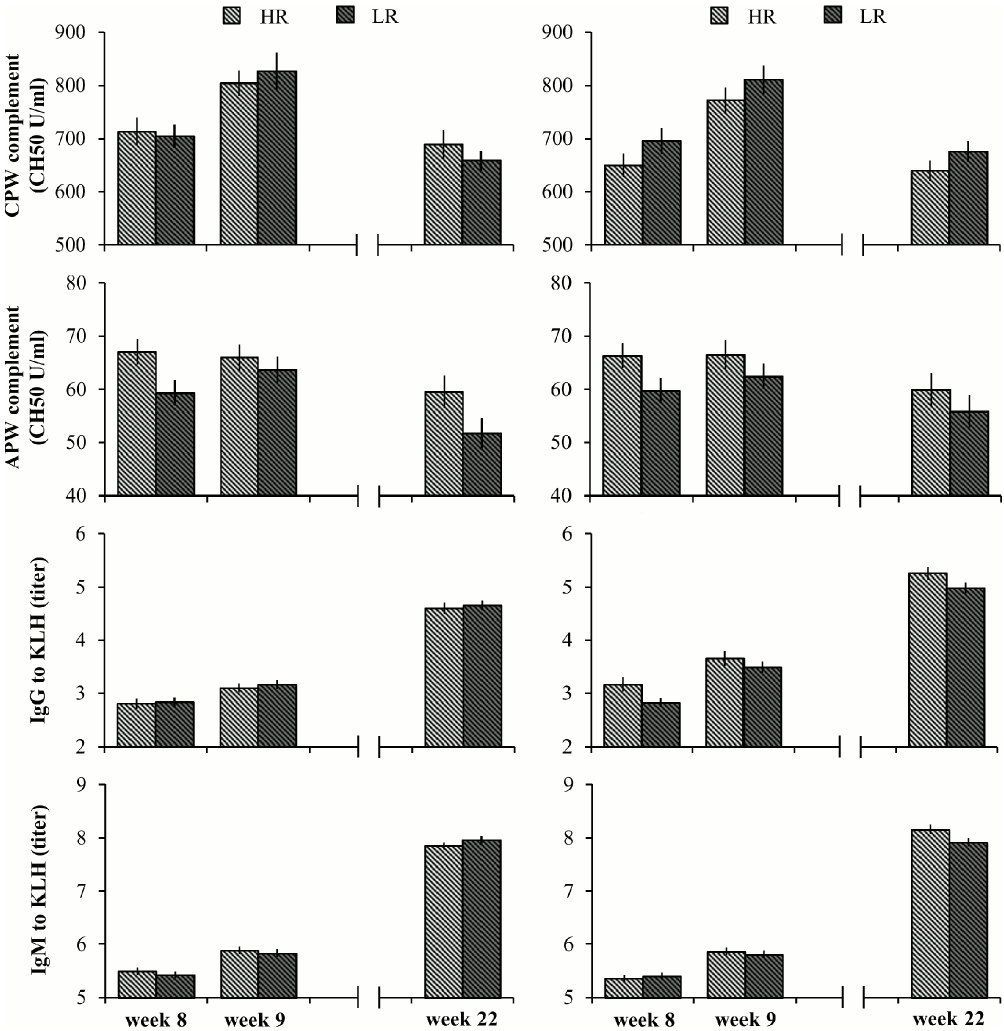
Figure 2. Means and SEM of complement activity and antibody titers. Compliment activity via the classical (CPW) (panels A and B) and alternative pathway (APW) (panels C and D), and IgG (panels E and F) and IgM titers (panels G and H) to Keyhole Limpet Hemocyanin (KLH) of pigs with a high-resisting (HR) and low-resisting (LR) backtest classification in barren and enriched housing measured before a 24 h regrouping test at 8 weeks of age, after the regrouping test at 9 weeks of age and at 22 weeks of age. Significance of effects of housing and backtest classification is given in the text.